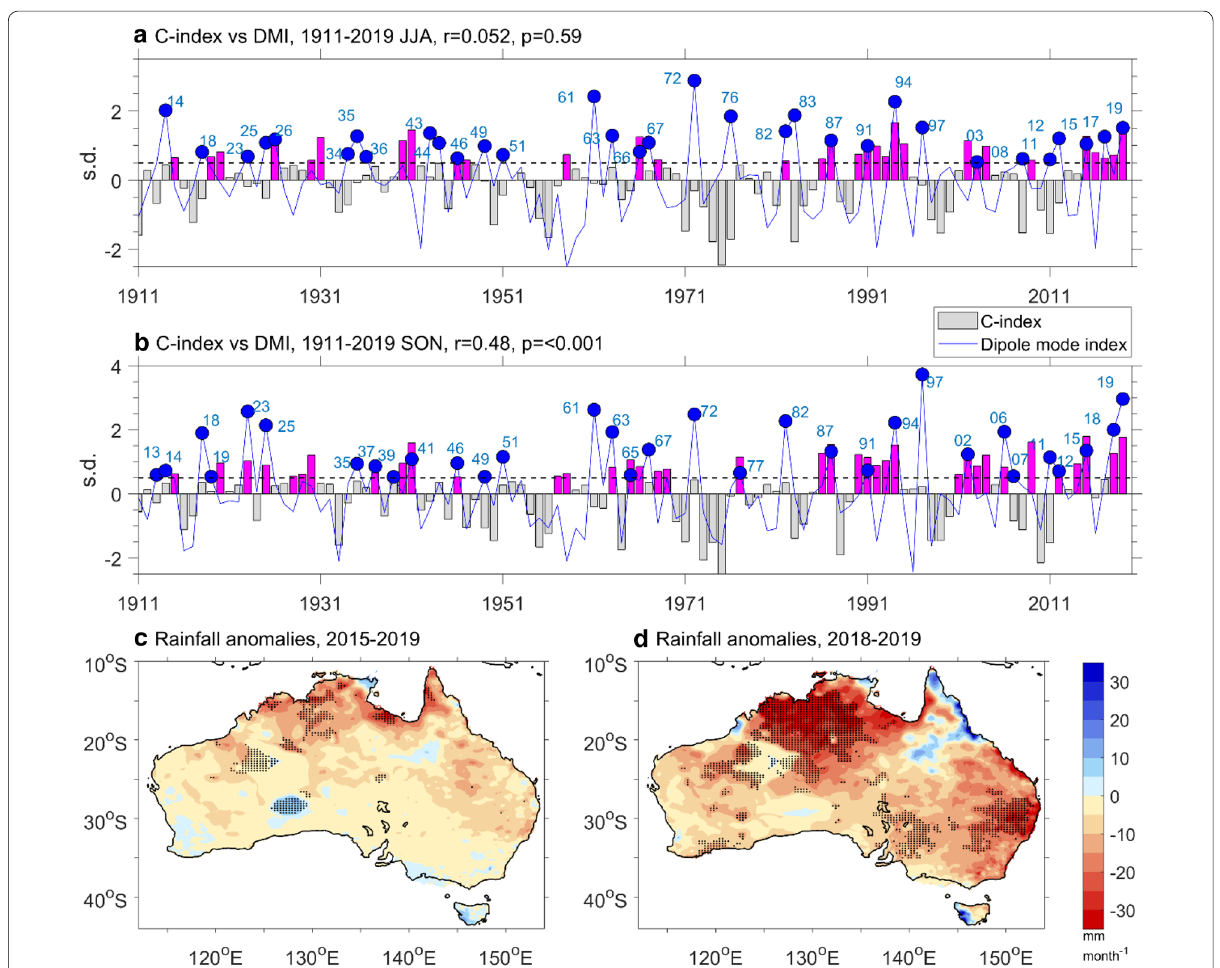
Fig. 2 The consecutive concurrences of CP El Niño and pIOD event and the recent severe drought over Australia. a A comparison between the JJA C-index (bars) and the JJA DMI (blue curve) from 1911 to 2019. The pink bars highlight CP El Niño years defined as when the C-index is greater than 0.5 s.d.; and a positive IOD event indicated by blue filled circle is defined as when the DMI is greater than 0.5 s.d. The correlation coefficient and p value are shown on the title. b The same as a but for the SON season. c Mean monthly rainfall anomalies over the recent five years, i.e., from 2015 to 2019. d , The same as c over the recent two years, i.e., from 2018 to 2019. Data are quadratically detrended before analysis. Dotted areas indicate regions where the anomalies are greater than a 2.0 s.d. value of the 5 year and 2 year running time series at each grid-points in c and d ,